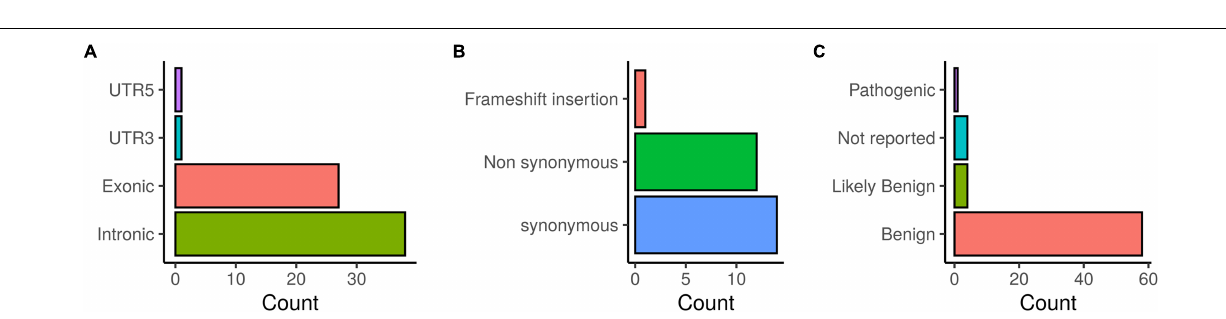
FIGURE 2 | Distribution of BRCA1/2 variations identified in patients investigated by target gene and whole exome sequencing. (A) SNVs/InDels distribution, (B) Distribution of coding variations, (C) ClinVar classification of detected